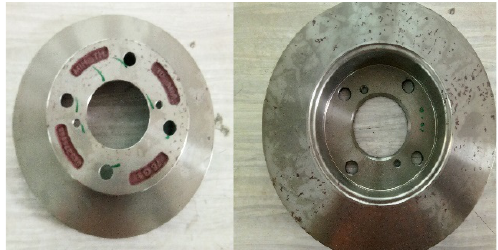
Figure 9. Brake Disc (Rotor Disc)